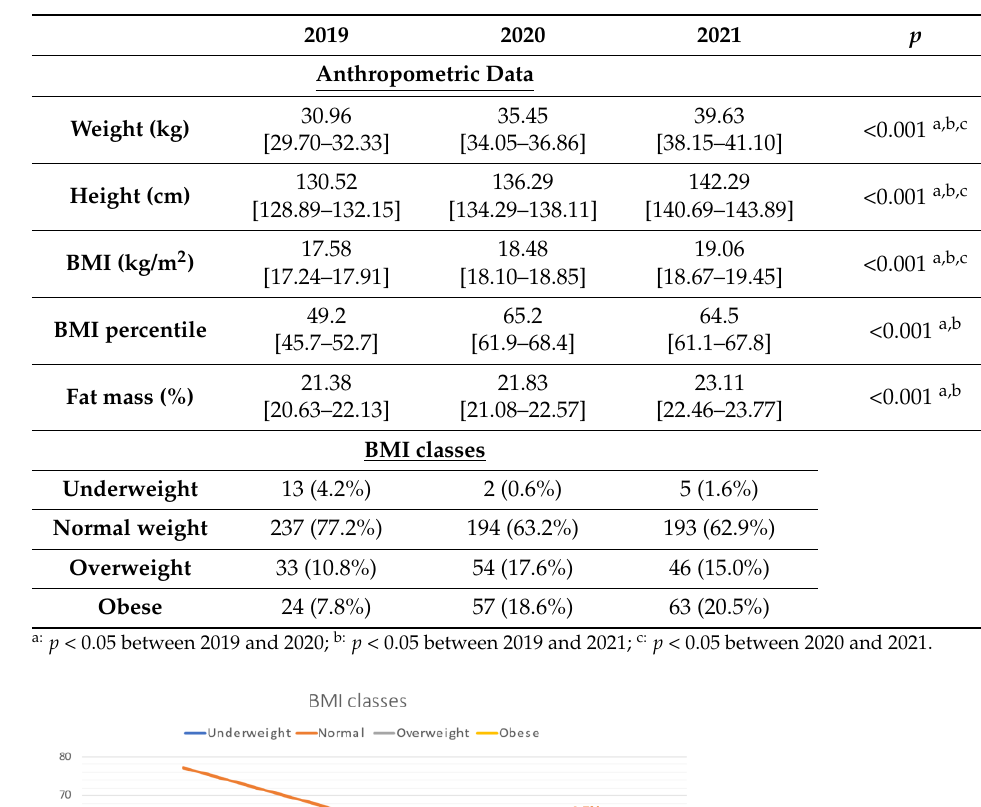
Table 1. Comparison of BMI of the same cohort of children ( n = 307) assessed in 2019, 2020, and 2021. Underweight was considered presenting a BMI below the 5th percentile, overweight between 85th and 94.9th percentile and obese above the 95th percentile.